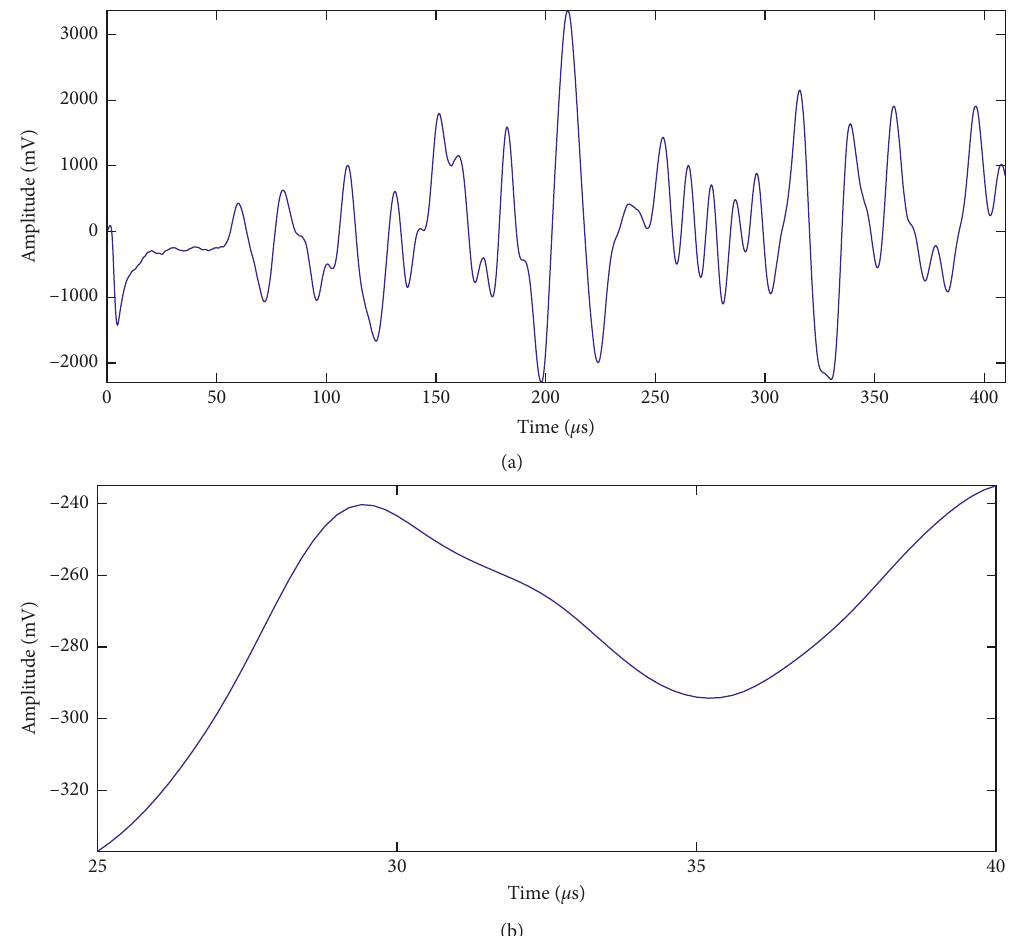
Figure 12: Time-domain curve (a) and minutiae (b) of nonlinear ultrasonic signals after